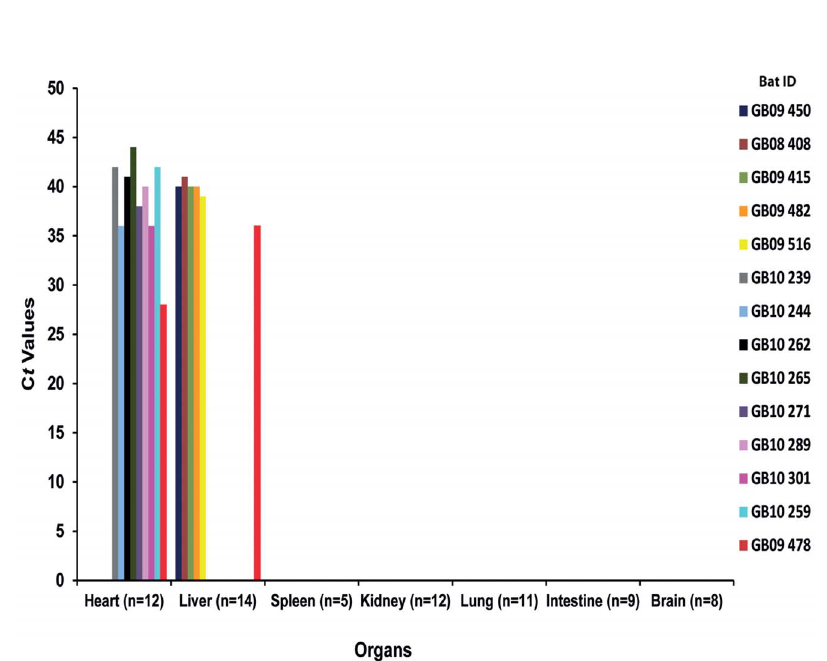
Fig. 2. Virus distribution in organs from Coleura afra individuals. Virus distribution is shown in terms of C t values on the y-axis for each bat organ tested (x-axis). n represents the number of organs available for the